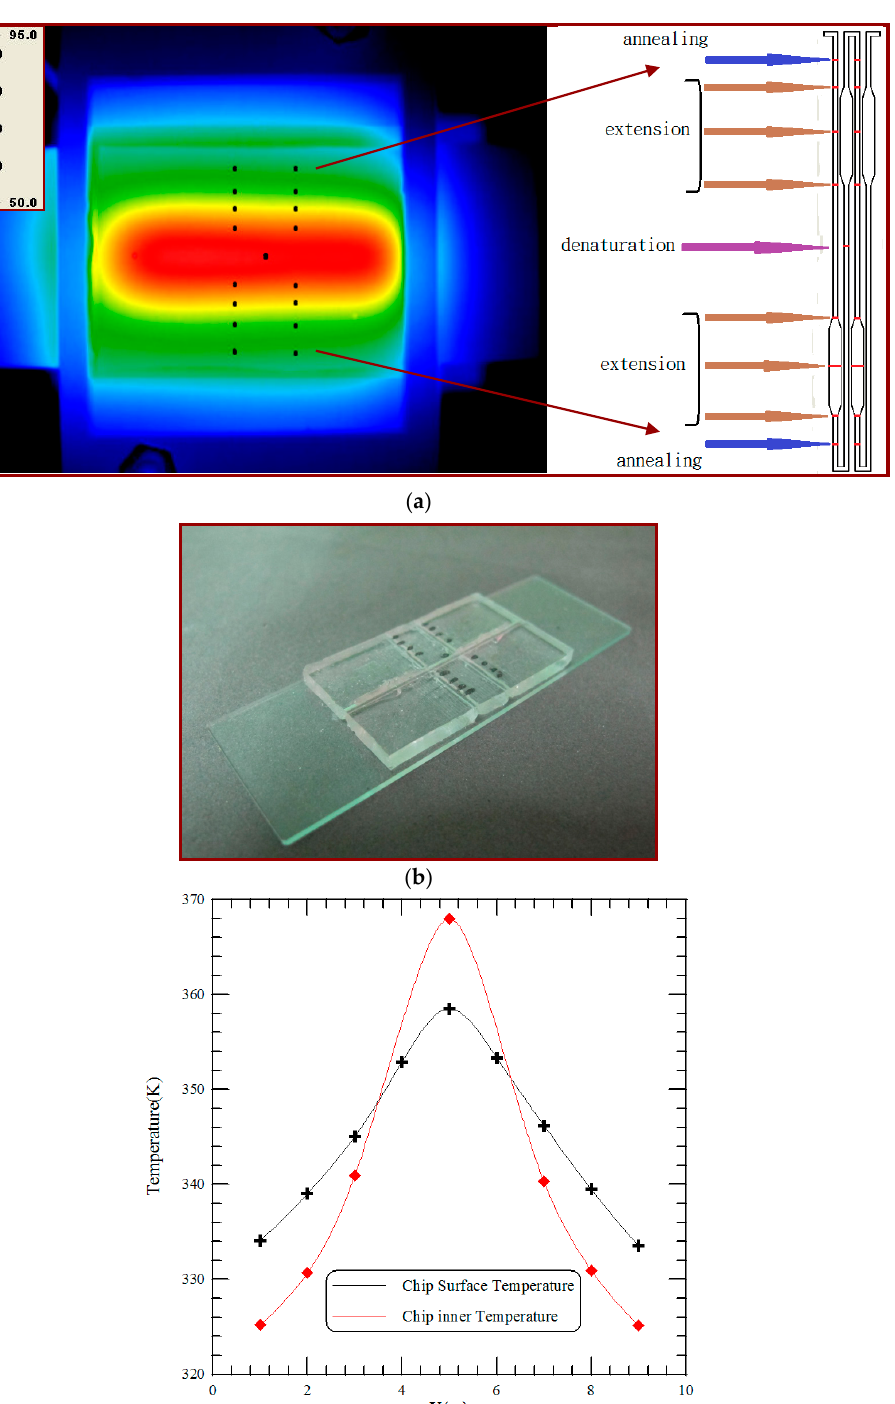
Figure 6. ( a ) The infrared (IR) image of the chip surface of the CFPCR device; ( b ) the channel temperatures are measured using thermocouples that are inserted into the chip; ( c ) the average temperature profiles for the IR image and the channel measurement.